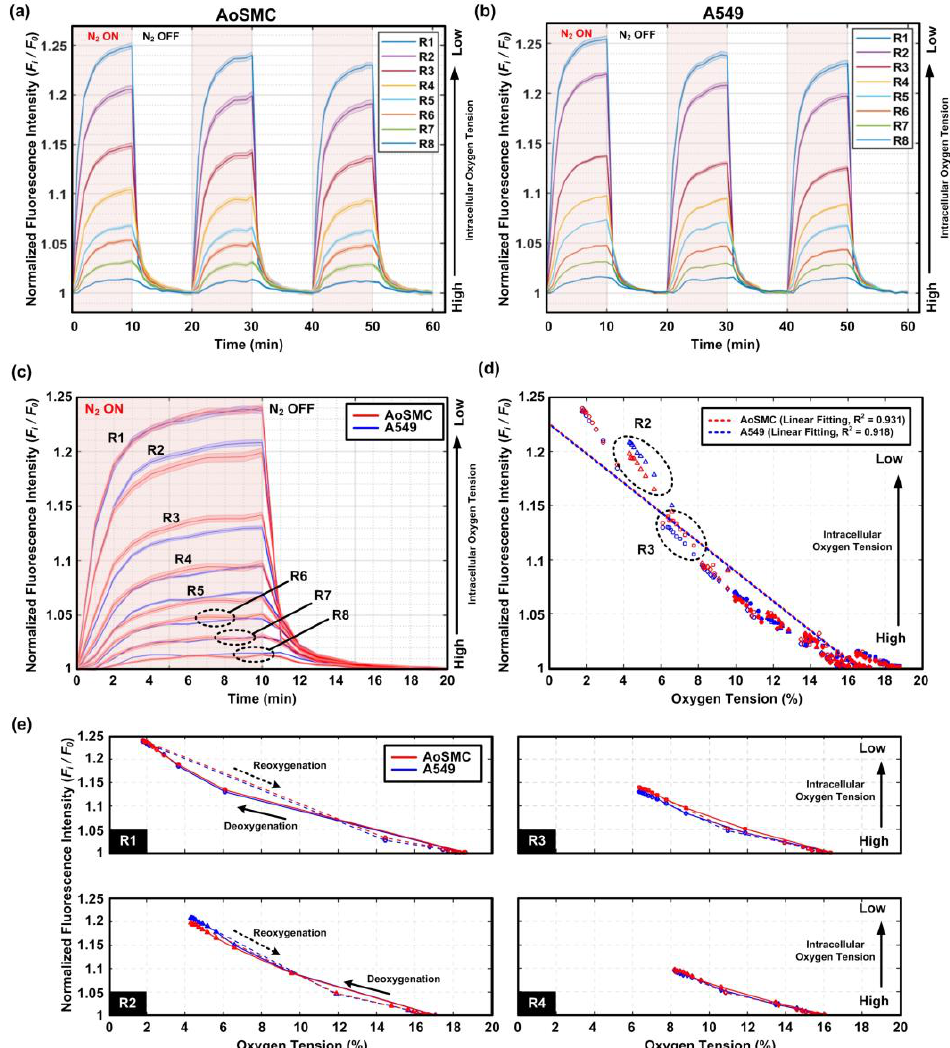
Figure 5. Temporal variation in the average normalized fluorescence intensities with the confidence bands (95% confidence interval) of the intracellular oxygen probes within the ( a ) AoSMCs and ( b ) A549 cells located in different regions across the width of the cell culture channel (left to right is R1 to R8, respectively). Red background regions indicate the periods when nitrogen gas is on (N 2 ON) for the oxygen gradient generation. ( c ) Comparison of the average normalized fluorescence intensities with the confidence bands (95% confidence interval) of the intracellular oxygen probes within the AoSMCs and A549 cells located in different regions (R1 to R8) during the period of one oxygen gradient/normoxia (N 2 ON/N 2 OFF) cycle. Intracellular oxygen probe shows discrepant fluorescence intensity between the AoSMCs and A549 cells located in R2 and R3. ( d ) Plot of the normalized fluorescence intensities of the intracellular oxygen probes under different oxygen tensions generated in the microfluidic device for the cultured AoSMCs and A549 cells. ( e ) The kinetics of the intracellular oxygen tension of the cells located in regions R1 to R4 during the deoxygenation and reoxygenation processes within a single period based on the fluorescence intensity observation. The solid and dotted lines show the intracellular oxygen tension responses during deoxygenation (N 2 ON) and reoxygenation (N 2 OFF) processes,